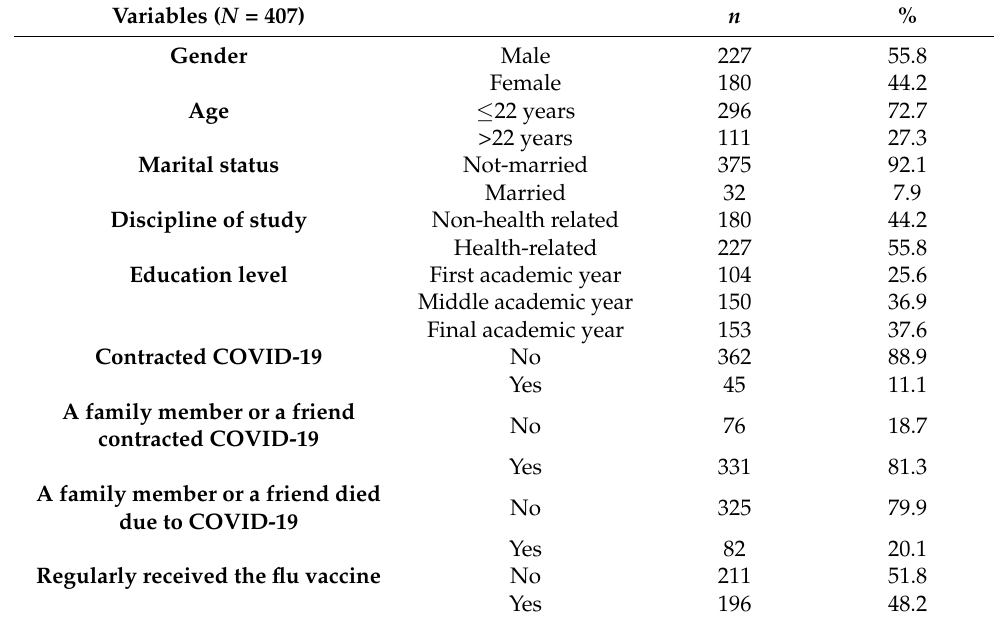
Table 1. Demographic information.